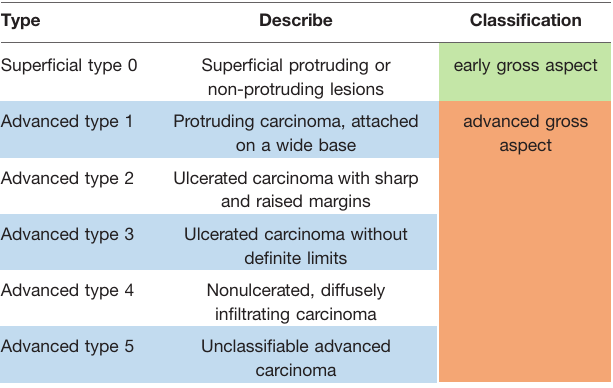
TABLE 2 | The goss aspect classi fi cation of digestive-tract